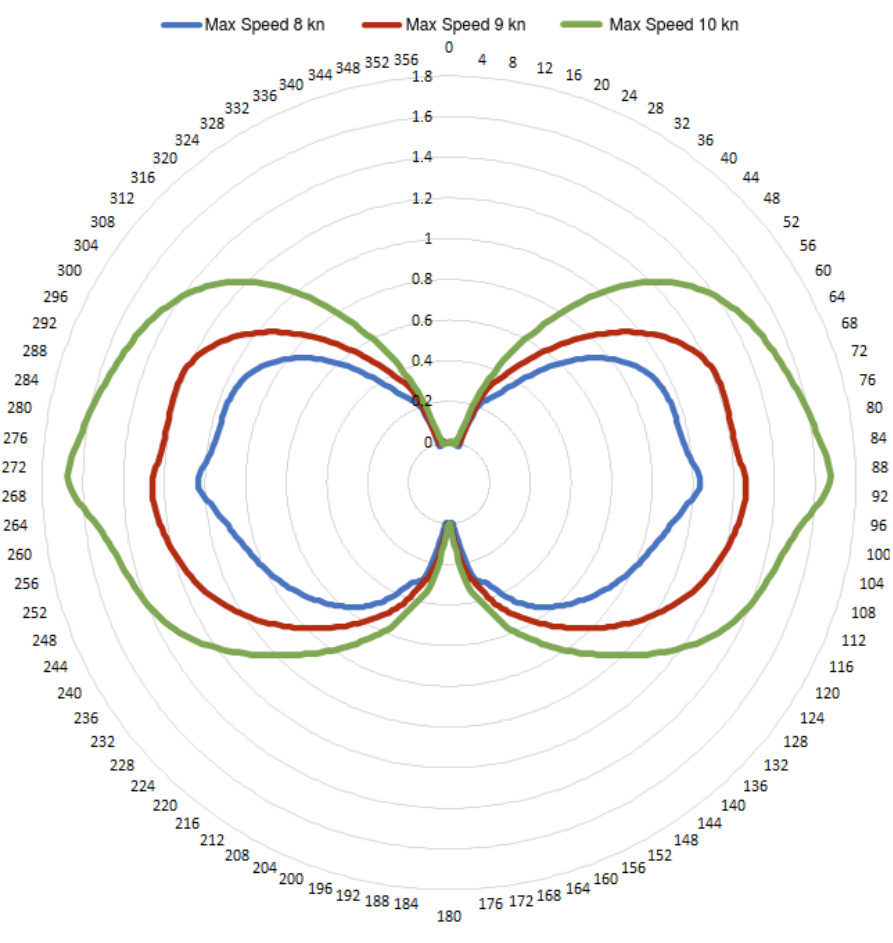
Figure 14. Land yacht polar